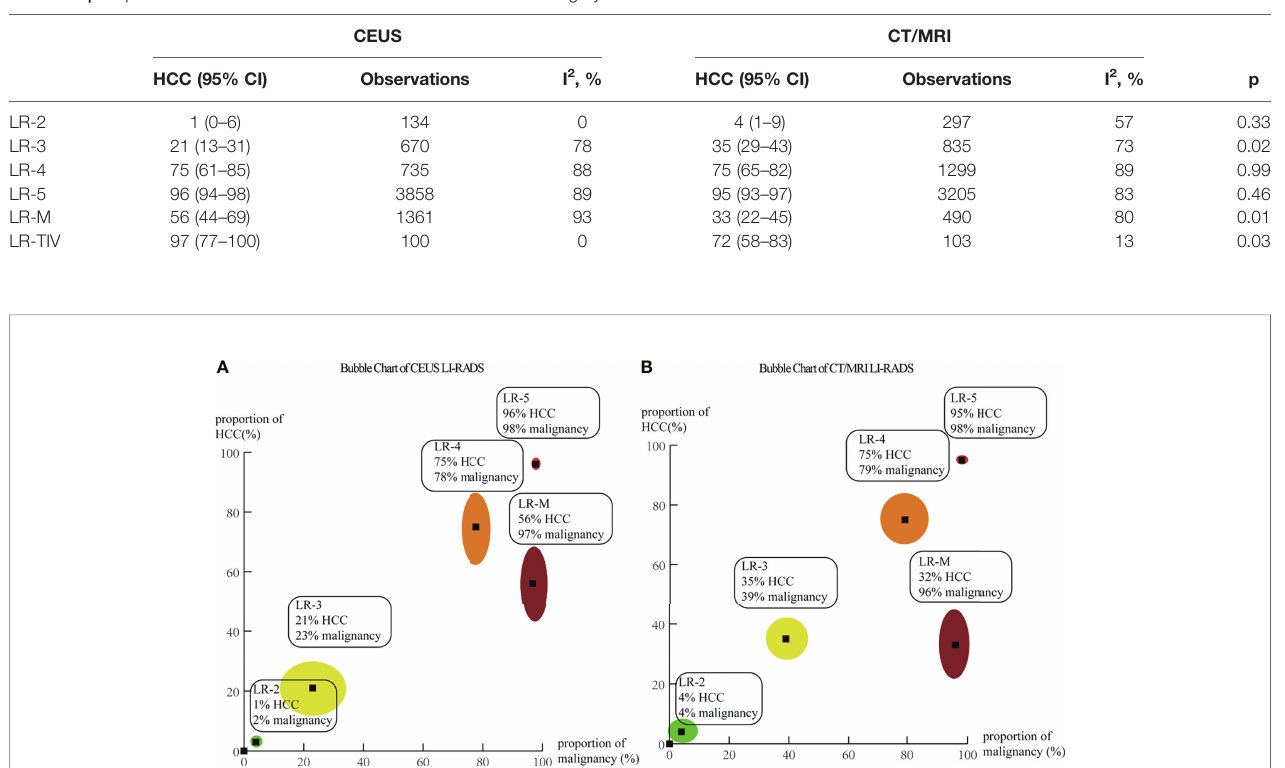
TABLE 1 | Proportions of HCCs in each CEUS and CT/MRI LI-RADS